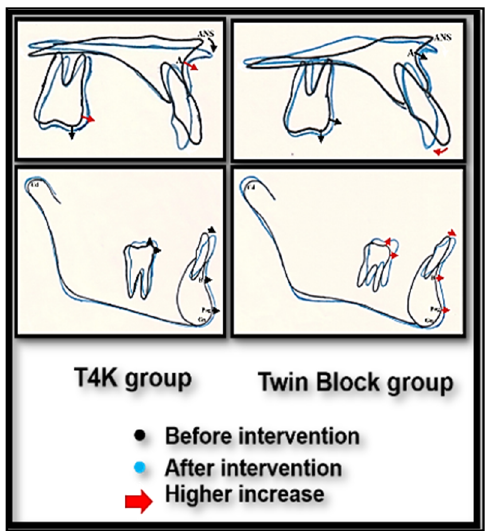
Figure 5. Photographs showing Superimposition of the maxilla and mandible before and after treatment in both the T4K and twin block groups. (Retroclination of the maxillary incisor, proclination of the mandibular incisor, mesial and vertical movement of the maxillary and mandibular permanent molars).